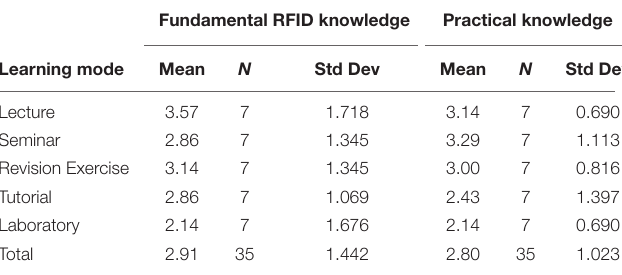
TABLE 3 | Group-based baseline measurements for learning performance.